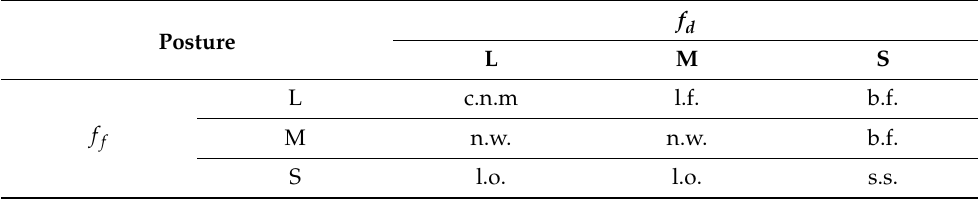
Table 2. Posture while in flat surface.